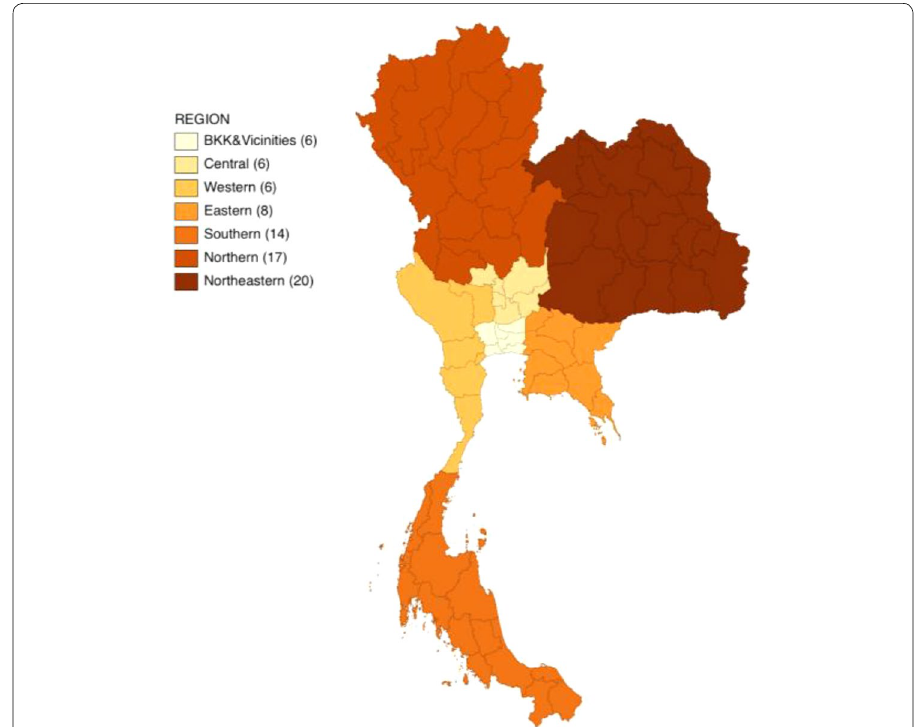
Fig. 1 Map of study regions in Thailand. Source : created by author using satellite data